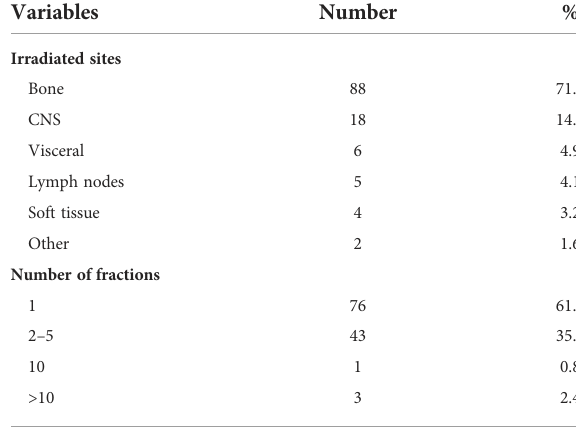
TABLE 2 Characteristics of palliative radiotherapy in 123